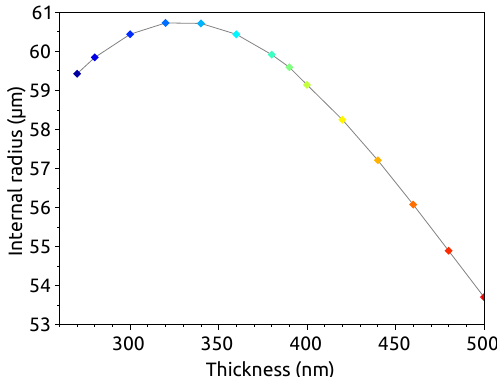
Figure 5. Internal radii values that fulfill the criteria of SHG with high efficiency as a function of the waveguide thickness. We assumed a silicon microring of width w = 800 nm and a fundamental azimuthal number m f = 400. The colors are the same as Figure 2b to ease the comparison between the two